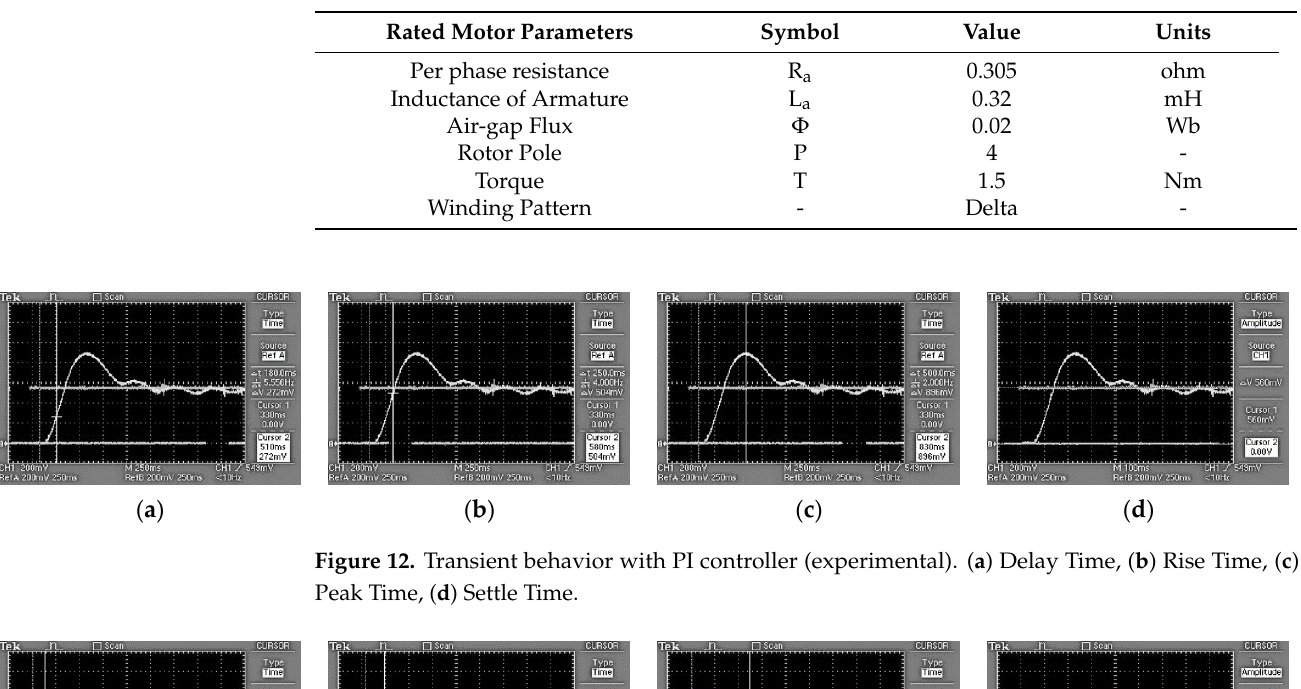
Table 7. Cont. Figure 11. Hardware setup depicting a five-phase intelligent controller-fed PMBLDC drive.